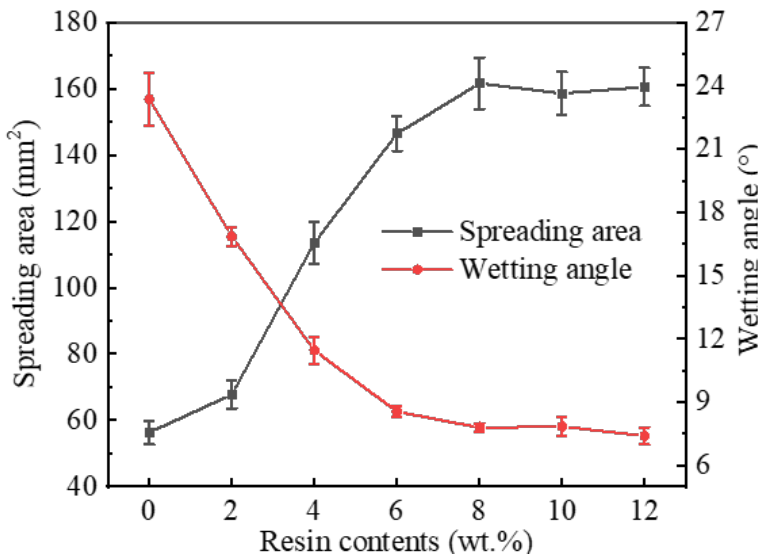
Figure 5. Spreading area and wetting angle of plain SAC305 and SAC305-ER solder pastes on Cu